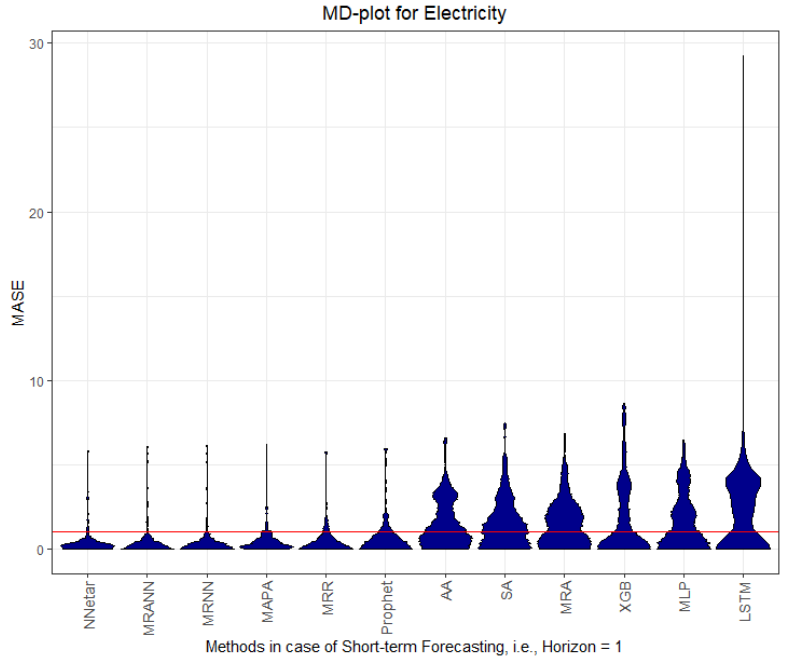
Figure 2. Mirrored density plot of Mean Absolute Scaled Errors (MASE) computed with a rolling forecasting origin for horizon 1 on dataset Electricity.